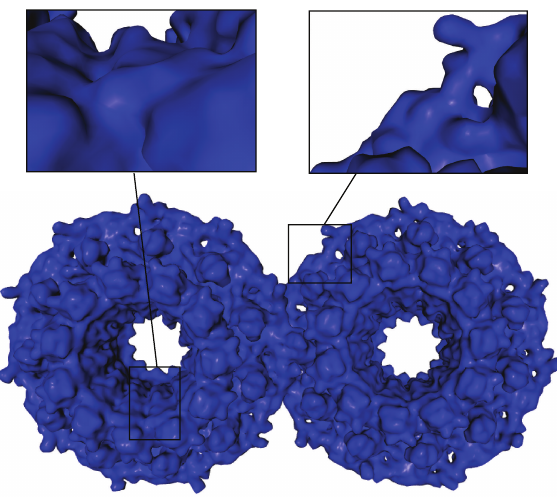
Figure 10: Mesh of the SES of a molecule with T e = 4 / 3 r s and k r = 1. (PDB Code: 1H2I).